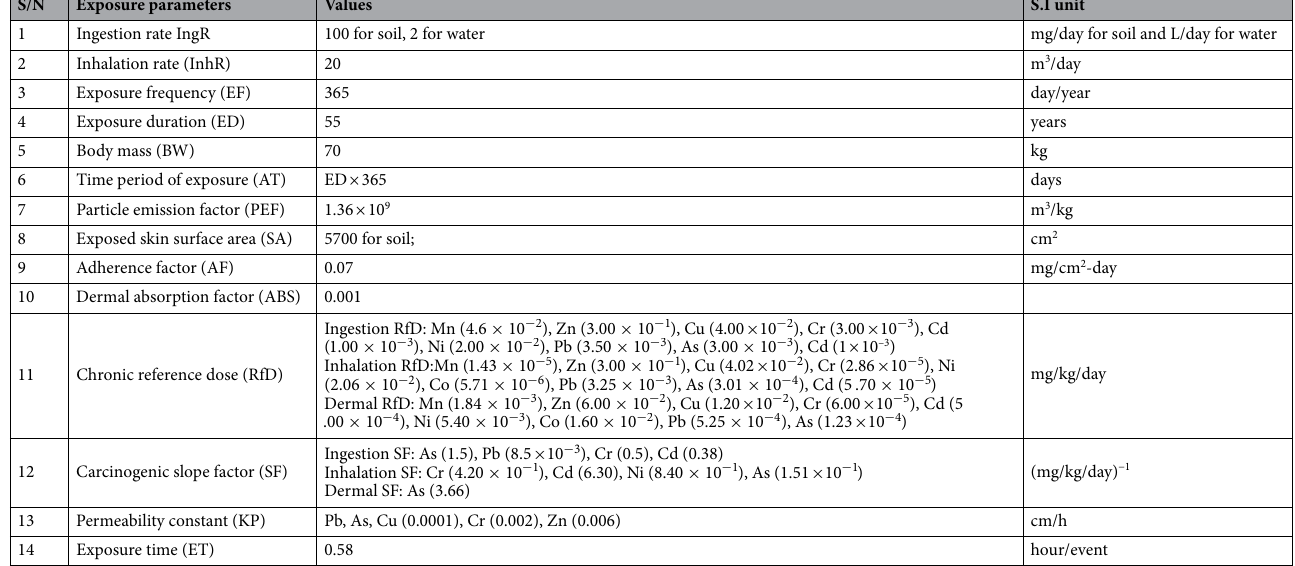
Table 12. Exposure parameters used in calculating the human health risks 31,38 .